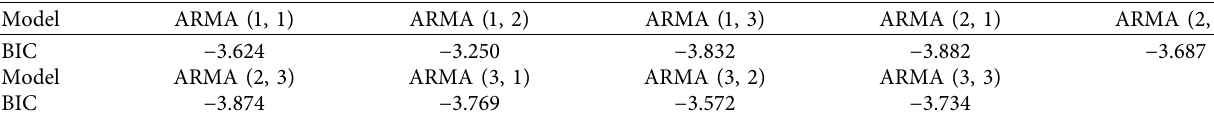
Figure 6: ACF and PACF of the detailed signal d Table 3: The values of BIC of ARMA models.